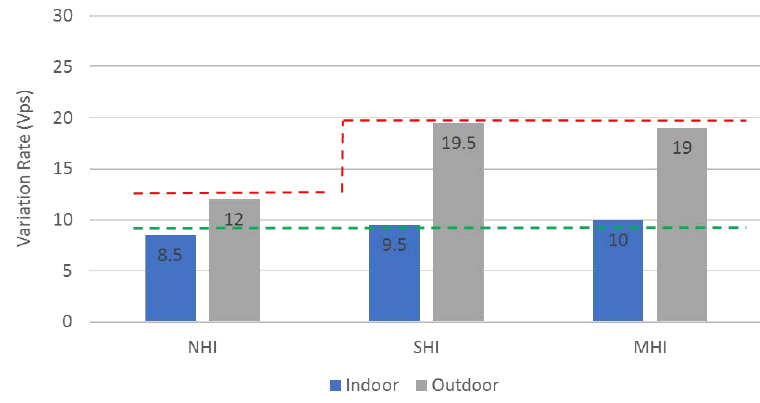
Figure 23. RSSI variation Comparison (Indoor vs.